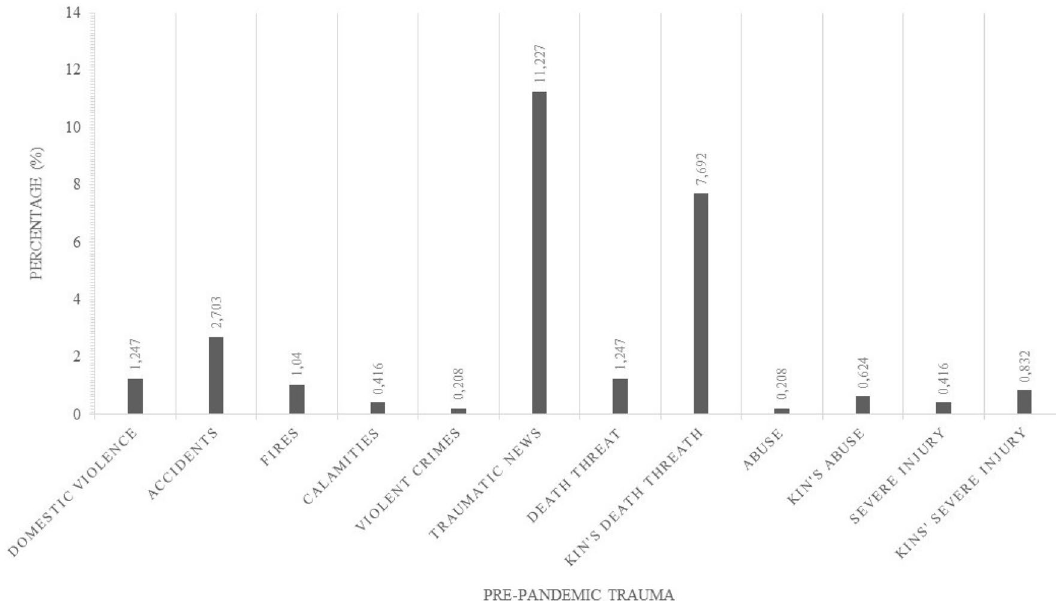
Figure 2. Pre-pandemic trauma reported.